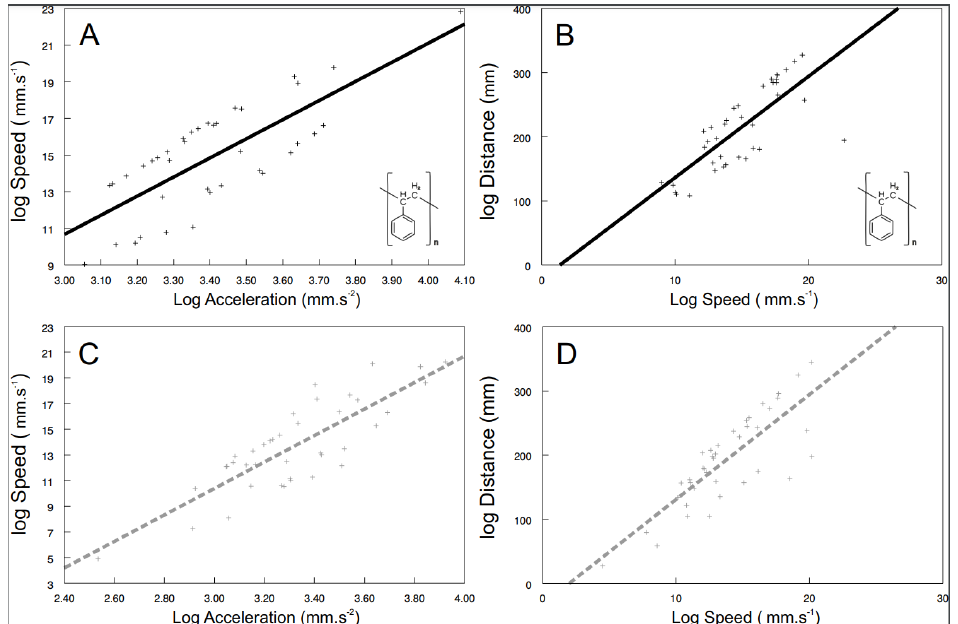
Figure 4. The relationship between speed and acceleration as well as distance and speed of exposed (( A , B ); black full line; polystyrene formula showed) and control (( C , D ); grey dashed line)) shrimps. Predicted values are from particular LMM models. The curves were fitted by: ( A ) y = 10.4147x − 20.5596 (r 2 = 0.58); ( B ) y = 15.7616x − 21.5961 (r 2 = 0.60); ( C ) y = 10.3123x − 20.5471 (r 2 = 0.68); ( D ) y=16.33x − 32.591 (r 2 = 0.67).